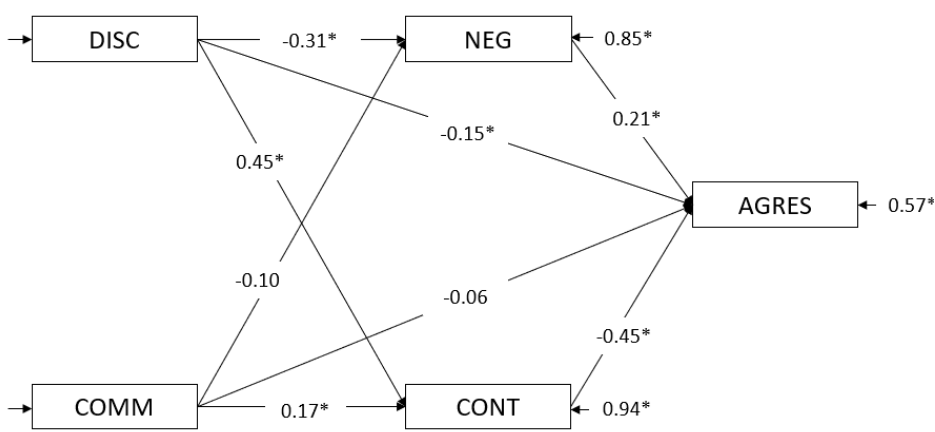
Figure 3. Mediational model for the 3–6-year-old group. Note: DISC = discipline; COMM = communication; NEG = negative affect; CONT = effortful control; AGRES = aggressive behavior. * p > 0.05.